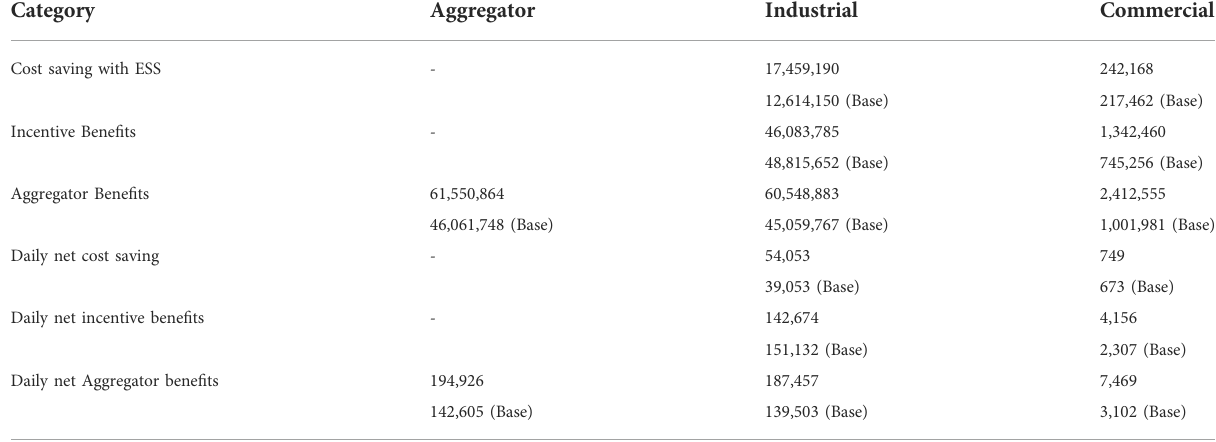
TABLE 5 Overall DR bene fi ts (in KRW).